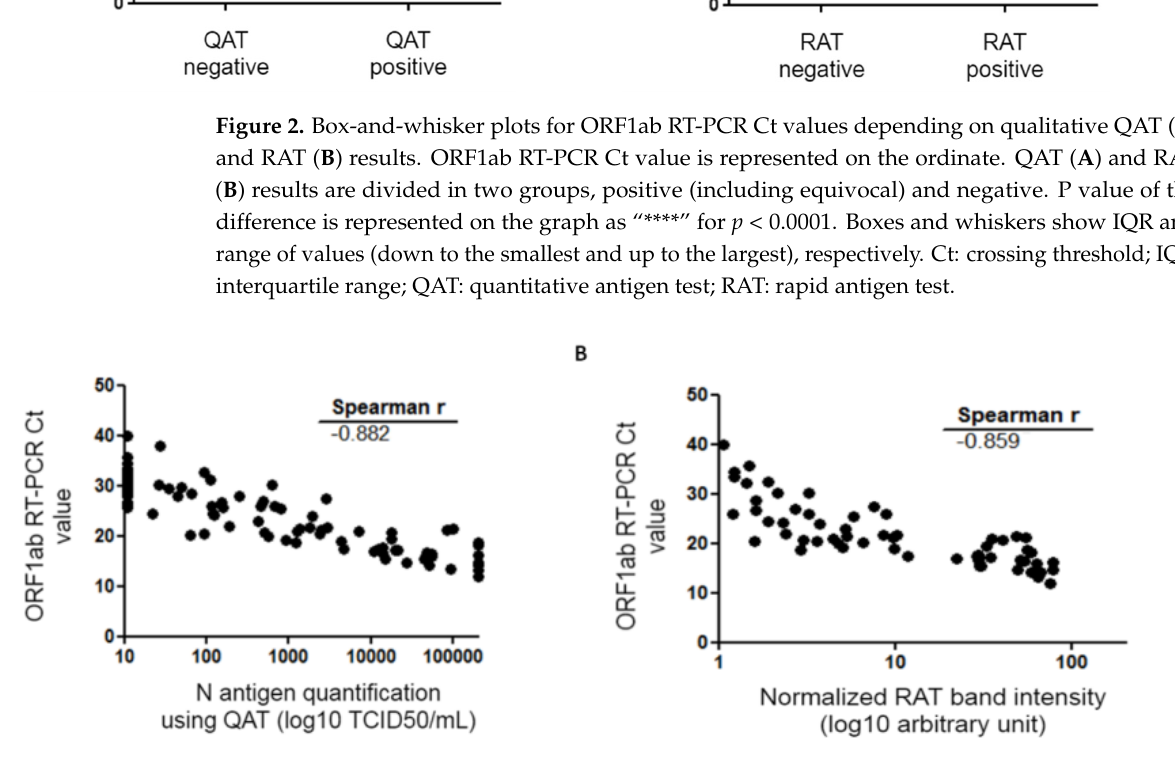
Figure 3. Spearman correlation of the QAT quantification ( A ) or RAT ( B ) and RT-PCR Ct value. QAT results are expressed as TCID 50 /mL (logarithmic scale) and represented on the abscissa ( A ). RAT quantitative results are expressed as band intensities (logarithmic scale) quantified using ImageJ ® tool after normalization and represented on the abscissa ( B ). ORF1ab RT-PCR Ct value is represented on the ordinate. Correlation coefficient r calculated with Spearman formula is shown on the graph. Ct: crossing threshold; N protein: viral nucleocapsid protein; QAT: quantitative antigen test; RAT: rapid antigen test; TCID 50 /mL 50% tissue culture infectious dose per milliliter.